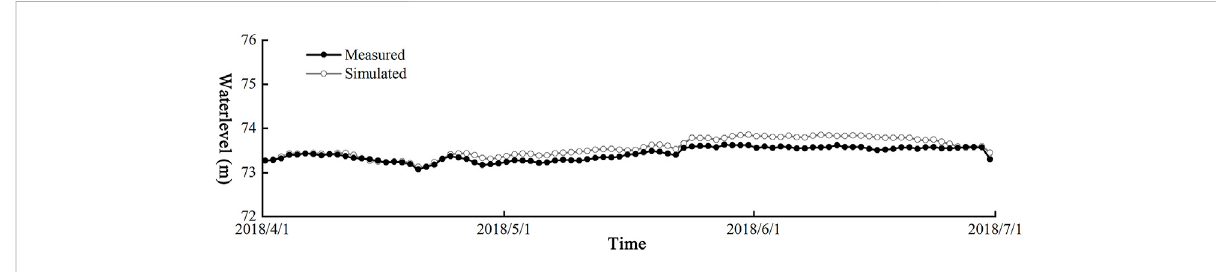
FIGURE 4 Veri fi cation results of the MIKE21 two-dimensional hydrodynamic model.